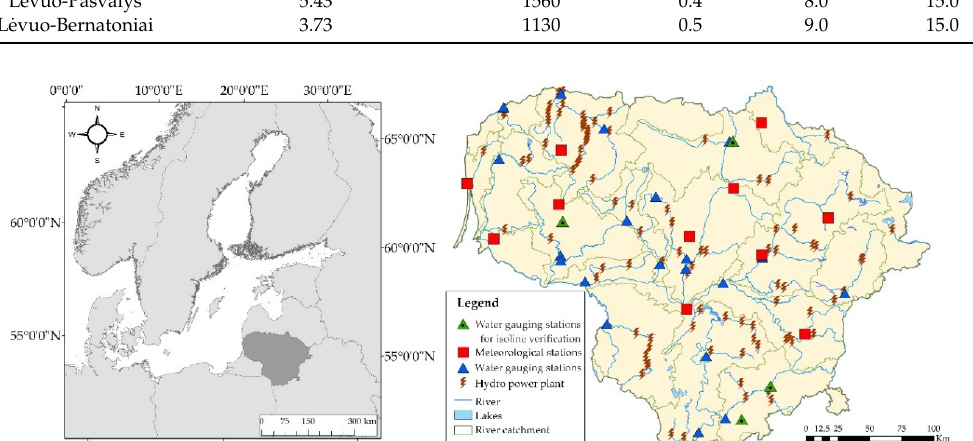
Figure 1. Study area and objects.